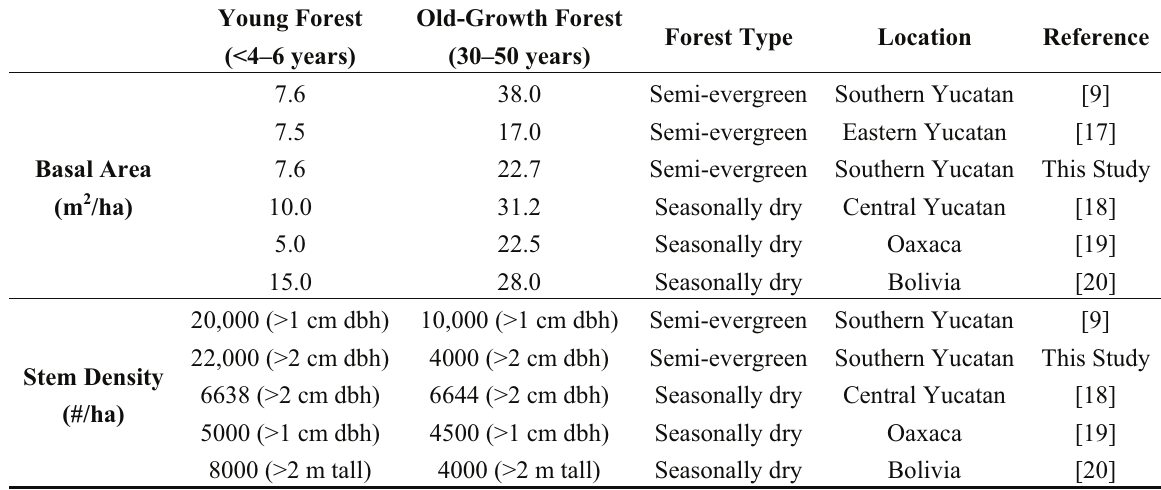
Table 1. Review of forest structural reference values among successional studies conducted in the Yucatan Peninsula and other similar tropical